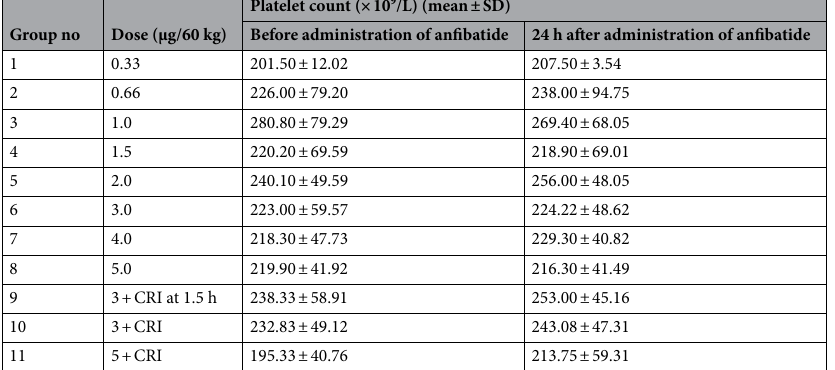
Platelet count (× 10 9 /L) (mean ± SD) Group no Dose (µg/60 kg) Before administration of anfibatide 24 h after administration of